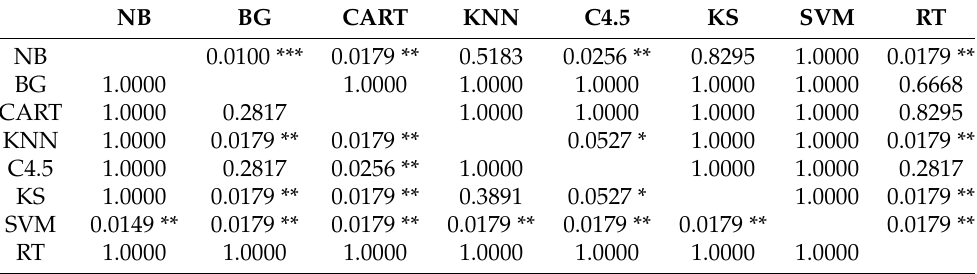
Table 14. Pairwise WSR Test for kappa statistics of children.